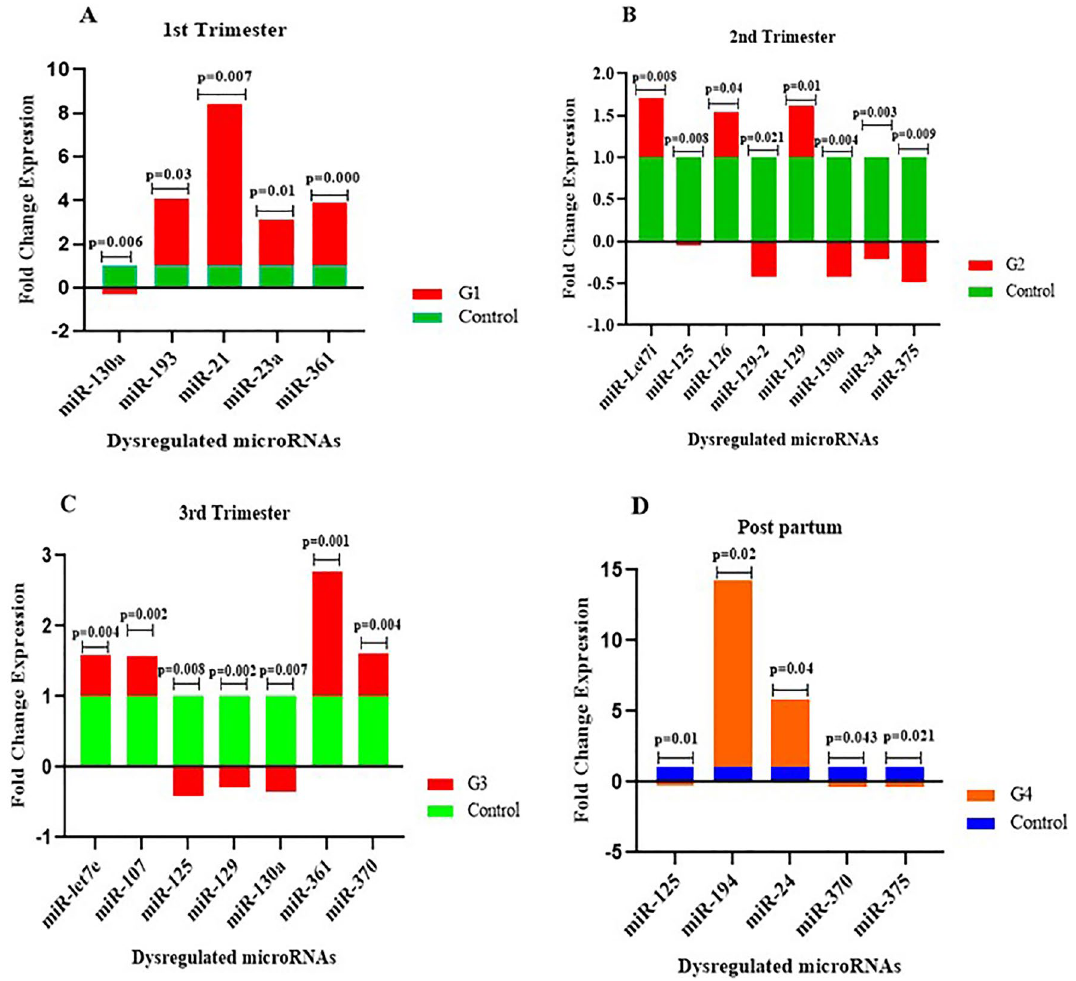
Figure 2. Dysregulated expression pattern of microRNAs in First ( A ), Second ( B ), Third ( C ) and postpartum ( D ) in GDM patients. Charts were derived from Graf Pad Prism version8. P -value calculated using non- parametric analytical